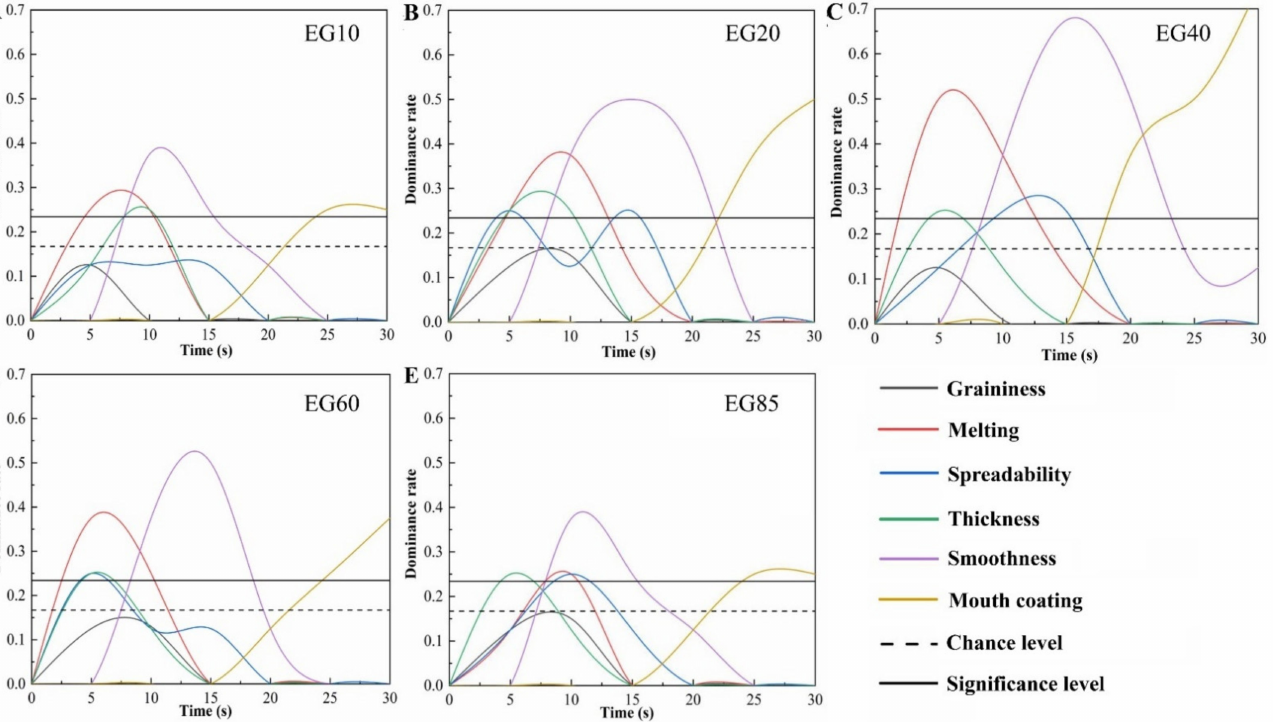
Figure 6. Temporal dominance of sensations curves of acid milk gels with different solid fat contents. ( A – E ) Acid milk gels: EG10, EG20, EG40, EG60 and